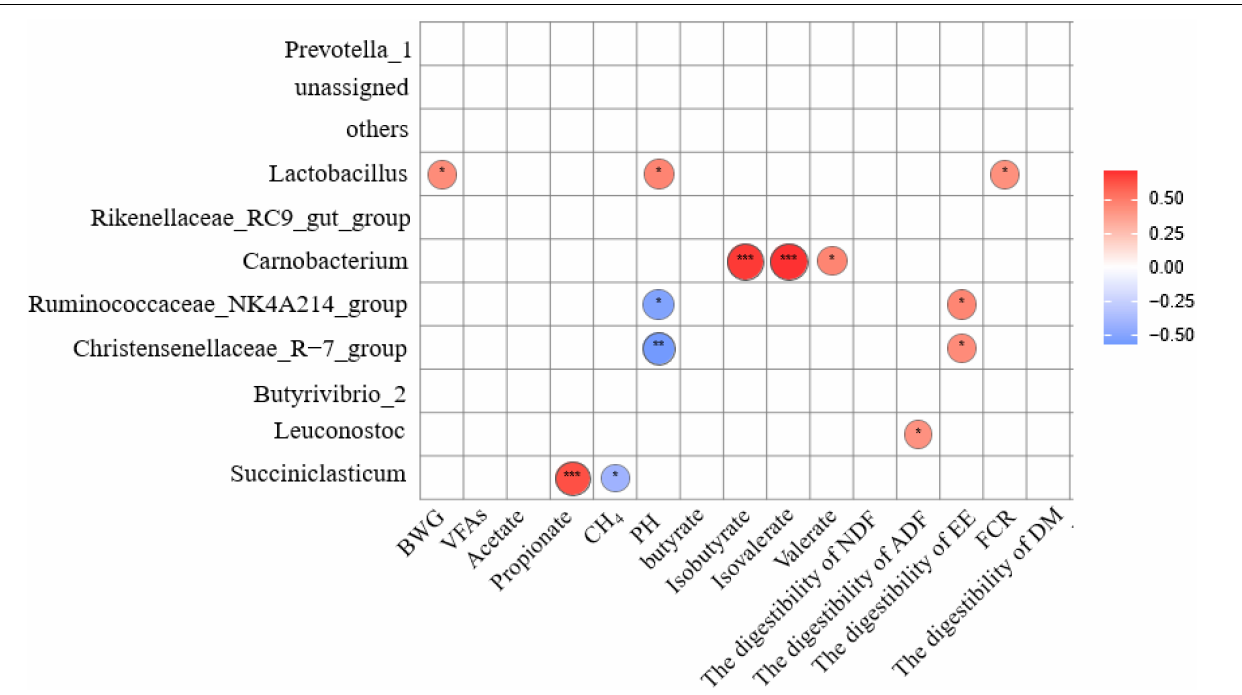
FIGURE 5 | Spearman correlation and clustering analysis between Rumen fermentation parameters, rumen digestive metabolism, Growth Performance and main bacteria in Genus level. The area of the circle represents the magnitude of the correlation, and different colors represent either a positive correlation (red) or a negative correlation (blue), *represents 0.01 < P ≤ 0.05, **represents P ≤ 0.01, ***represents P ≤ 0.001. BWG, bodyweight gain; FCR, feed conversion ratio (the ratio of BWG divided by the total DMI); VFAs, total volatile fatty acid; EE, ether extract.